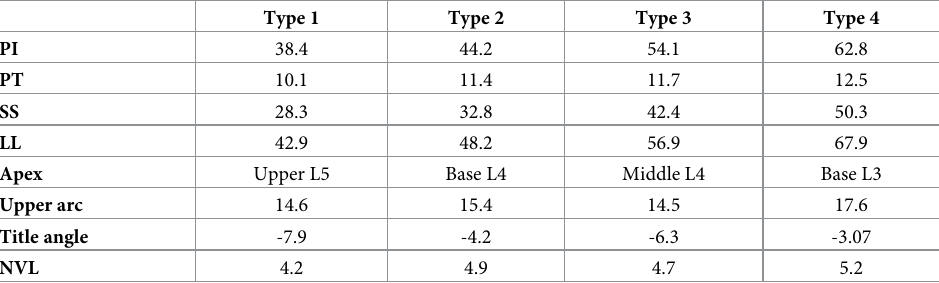
Table 3. Spino-pelvic parameters of Roussouly’s type finite element